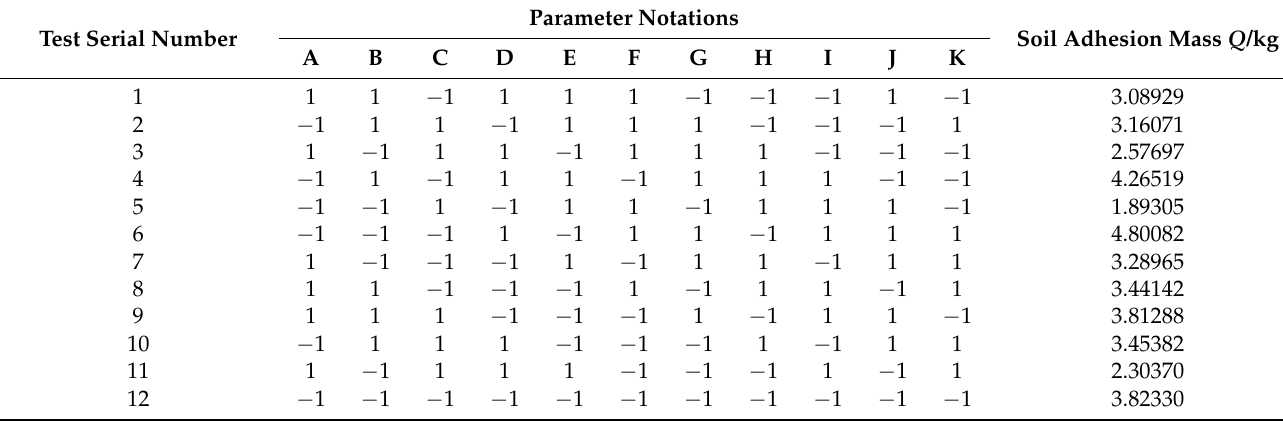
Table 3. Results of Plackett-Burman